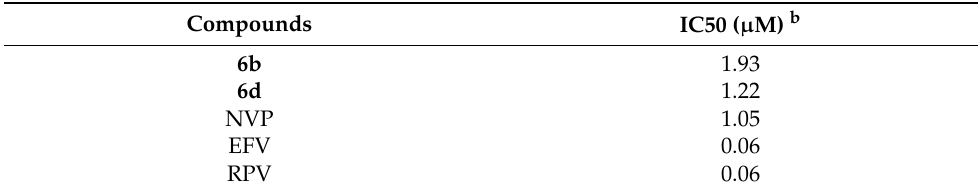
Table 3. Inhibitory analysis of 6b , 6d , NVP, EFV, and RPV against HIV-1 RT a